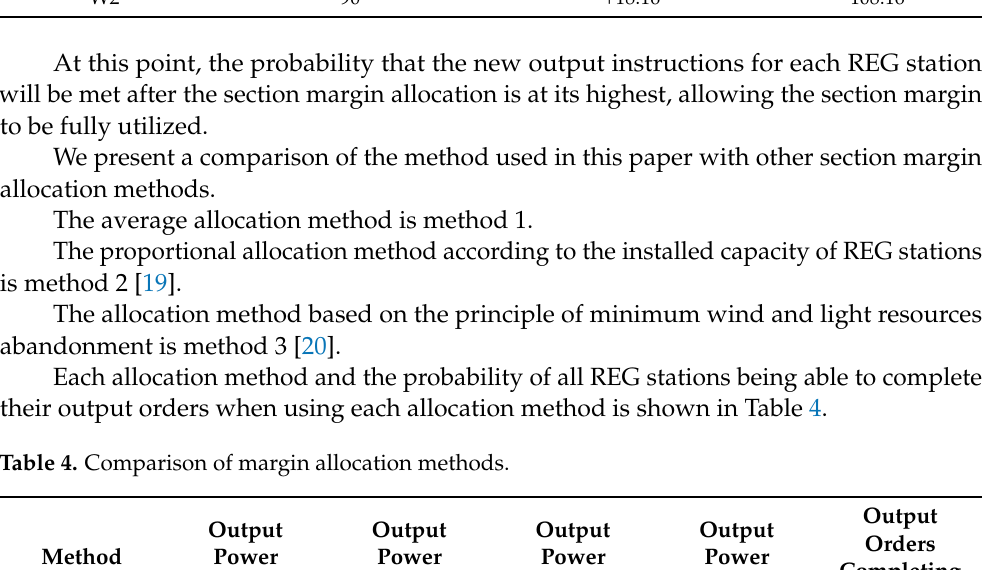
Figure 7. Probability that each REG station can achieve the expected output. SM P At this point, the section margin is 21 MW. According to the section margin t allocation function, the objective is to maximize the probability that all REG stations in the REG cluster can meet the output command after the margin allocation.